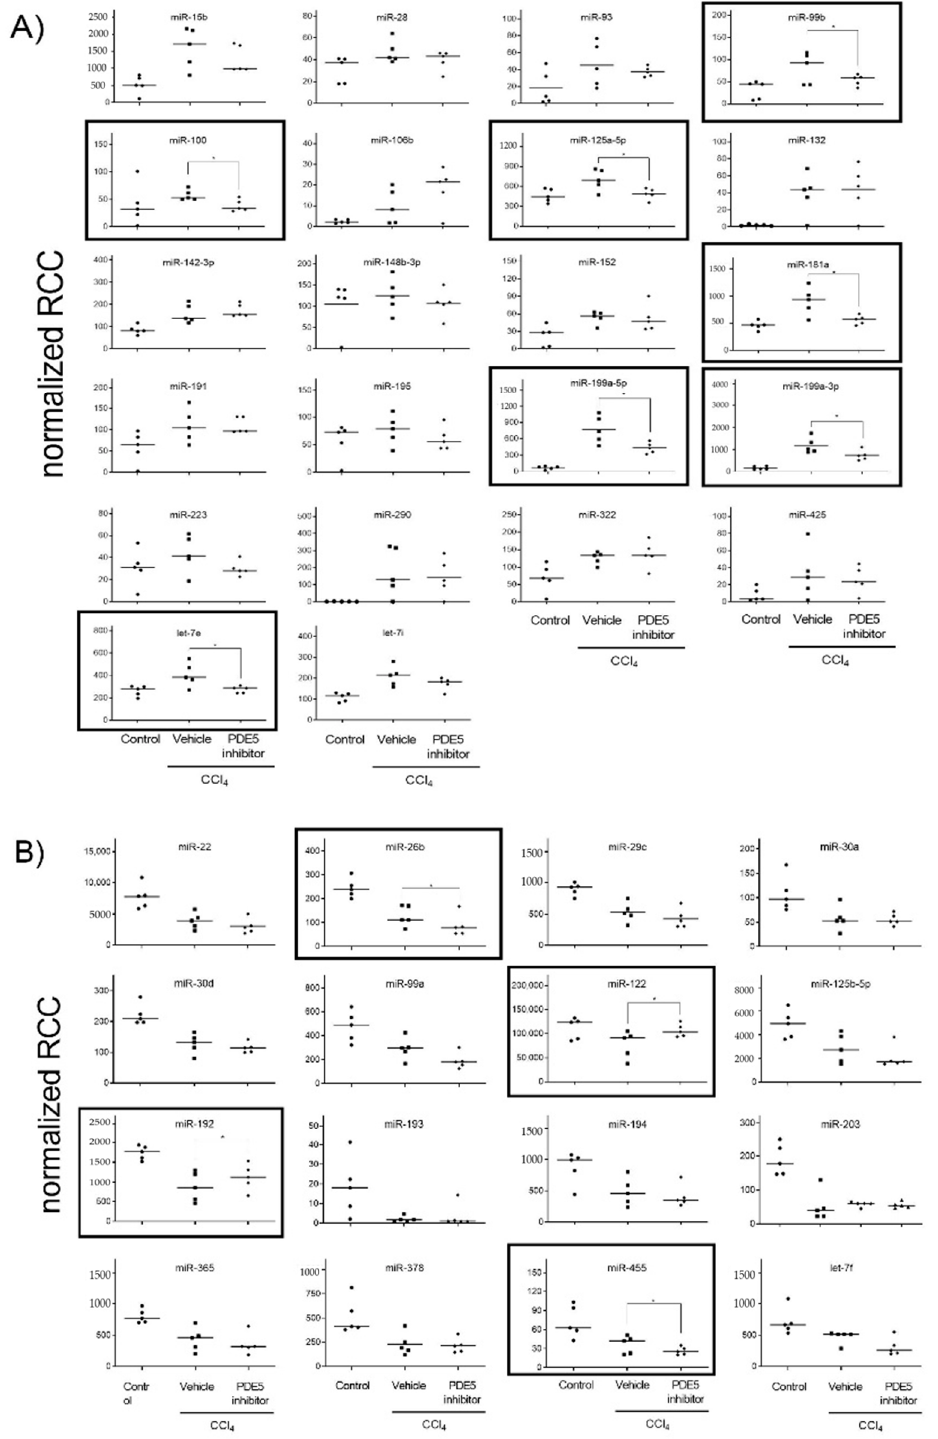
Figure 2. Up ‐ regulated ( A ) and down ‐ regulated ( B ) hepatic miRNA expression. MiRNA levels of Figure 2. Up-regulated ( A ) and down-regulated ( B ) hepatic miRNA expression. MiRNA levels of control, CCl 4 /Vehicle control, CCl 4 /Vehicle and CCl 4 /PDE5 inhibitor treated rats revealed by Nanostring analysis. and CCl 4 /PDE5 inhibitor treated rats revealed by Nanostring analysis. Absolute values are displayed for each animal by Absolute values are displayed for each animal by normalized reporter cell counts (RCC). MiRNAs normalized reporter cell counts (RCC). MiRNAs whose expression is significantly changed in one of the treatment groups whose expression is significantly changed in one of the treatment groups are highlighted with are highlighted with boxes. * p < boxes. * p < 0.05.